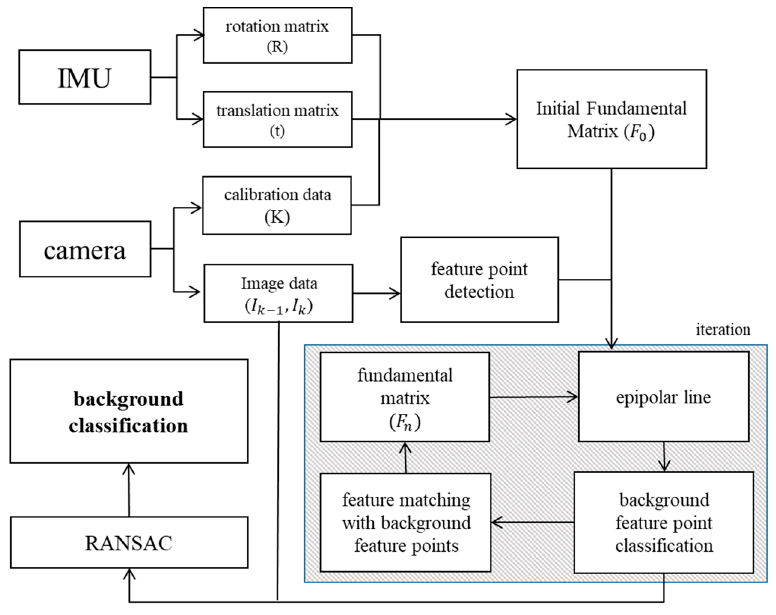
Figure 2. The proposed background classification method.